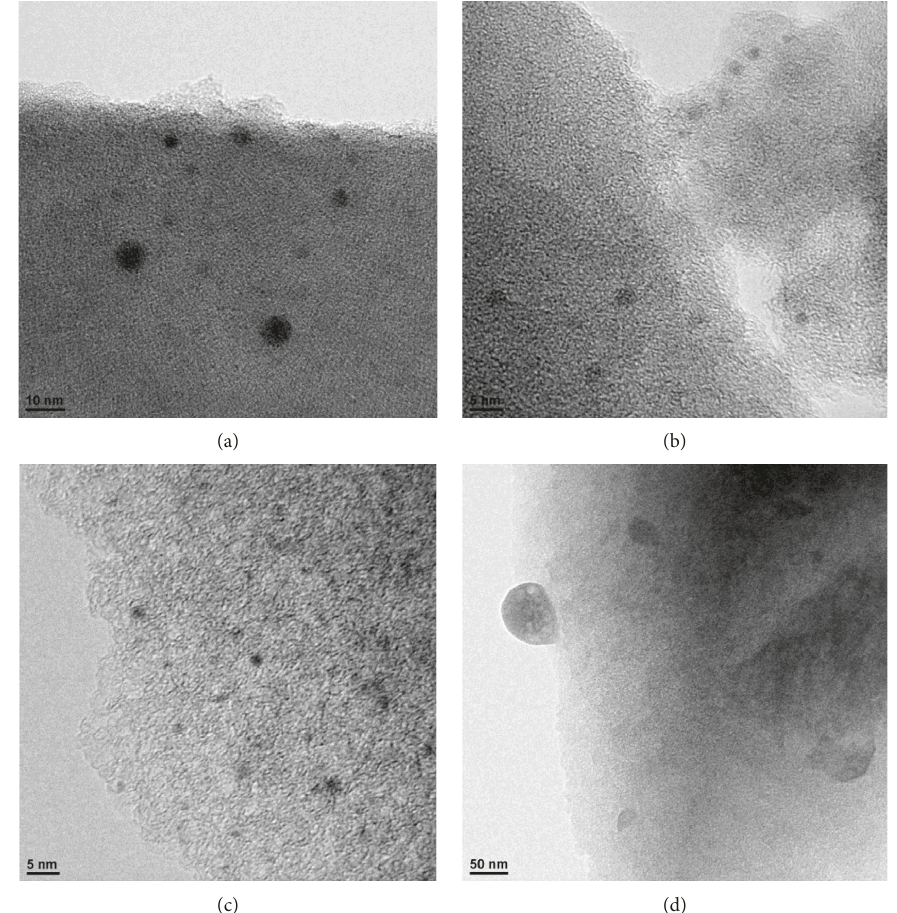
Figure 7: TEM Images for (a) PdN/C, (b) PdCl/C, (c) RuCl/C, and (d) NiCl/C